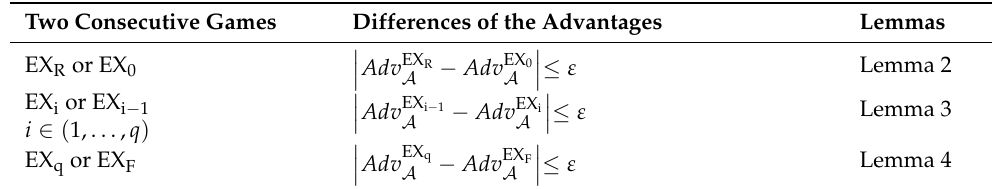
Table 3. The distinctions for the superiority achieved by the attacker between two consecutive games